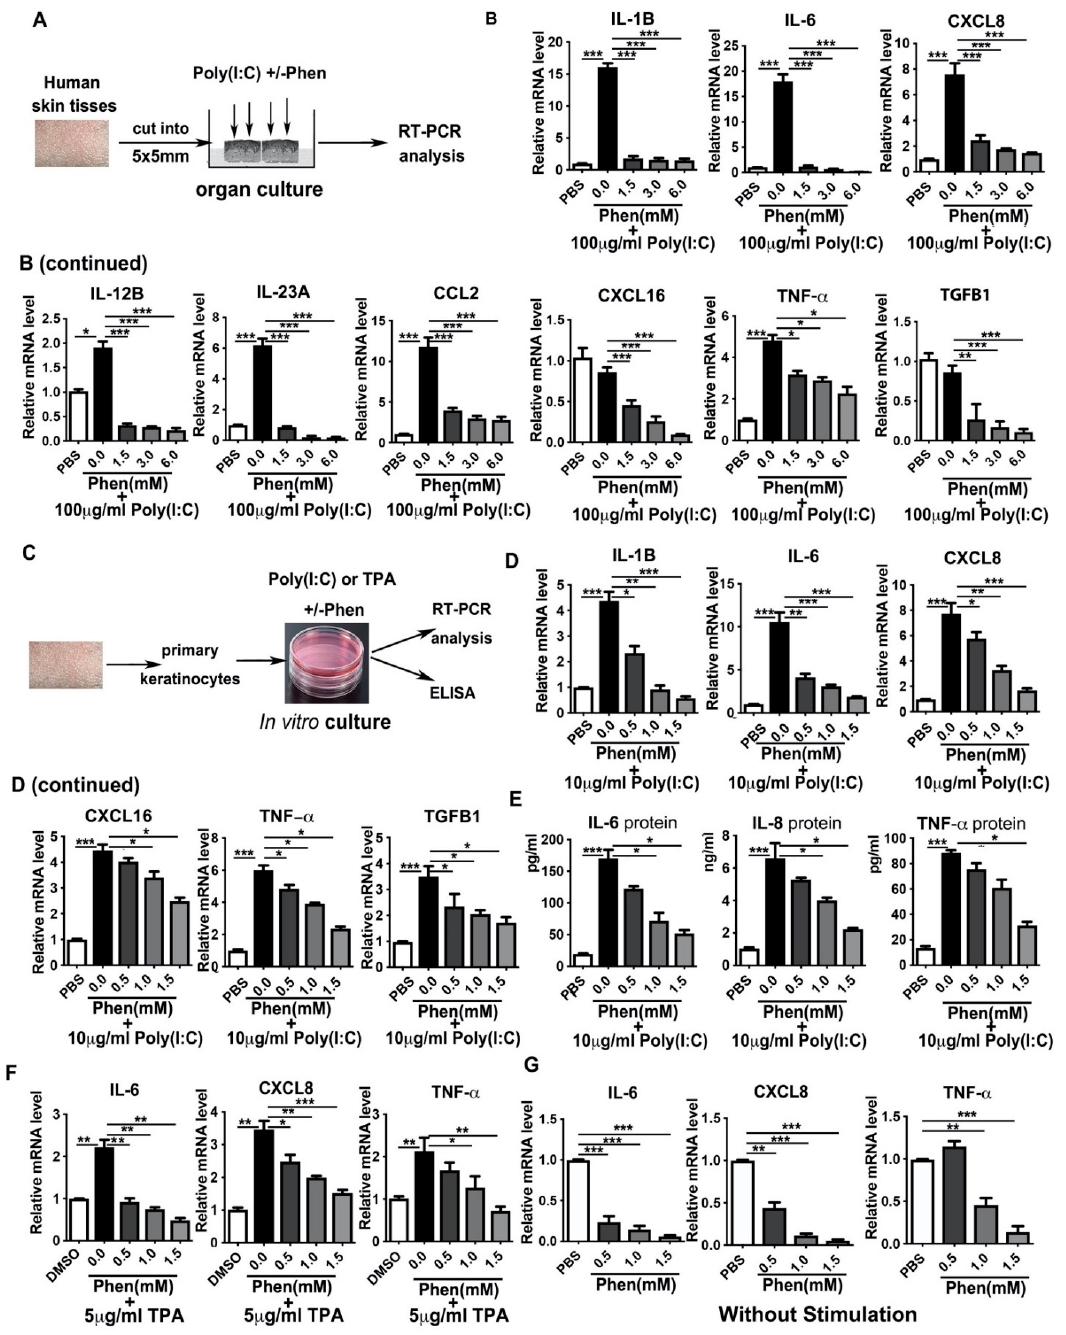
Figure 2. Phenformin suppresses the expression of pro-inflammatory cytokines in human keratinocytes. ( A ) Scheme of human skin organ culture: skin tissues were treated with 100 µ g/mL Poly (I:C) with or without different concentrations (0, 1.5, 3.0 or 6.0 mM) of phenformin (Phen) or PBS as a negative control for 24 h, then were collected for RT-PCR analysis of cytokine expression. ( B ) Total mRNAs were extracted from skin tissues from ( A ) and qRT-PCR was used to analyze the expression of the indicated pro-inflammatory cytokines; results were normalized to levels of 36B4 mRNA. ( C ) Scheme of in vitro culture of primary human keratinocytes treated with 10 µ g/mL Poly (I:C) or with 5 µ g/mL TPA with or without different concentrations (0, 0.5, 1.0 or 1.5 mM)